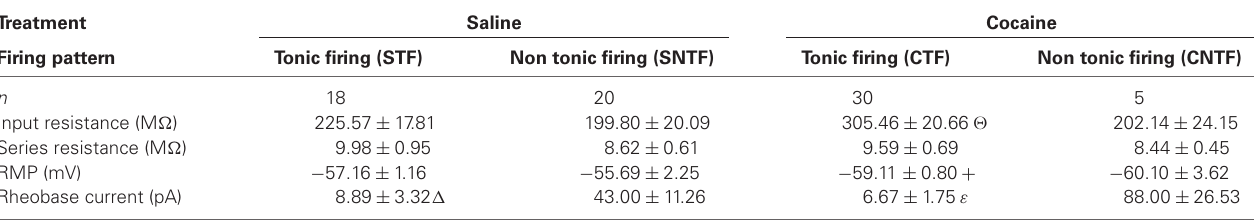
Table 1 | Passive membrane properties of aPVT neurons in saline- and cocaine-exposed animals .